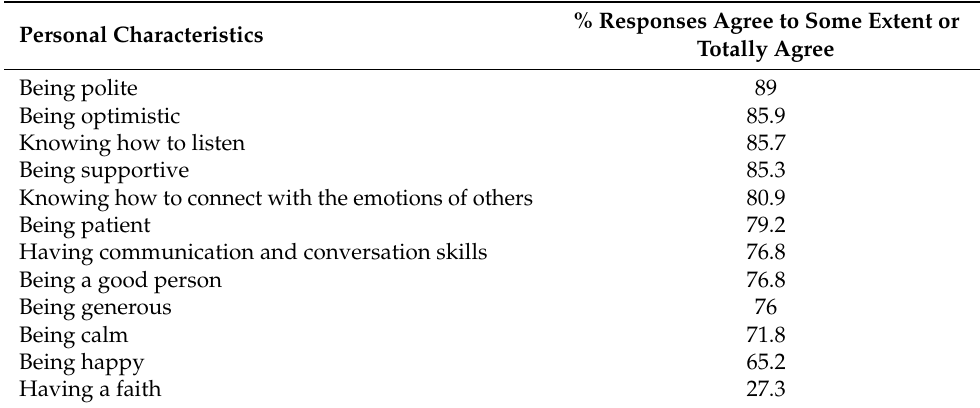
Table 2. Personal characteristics that a volunteer must have; % of favorable responses (agree to some extent or totally